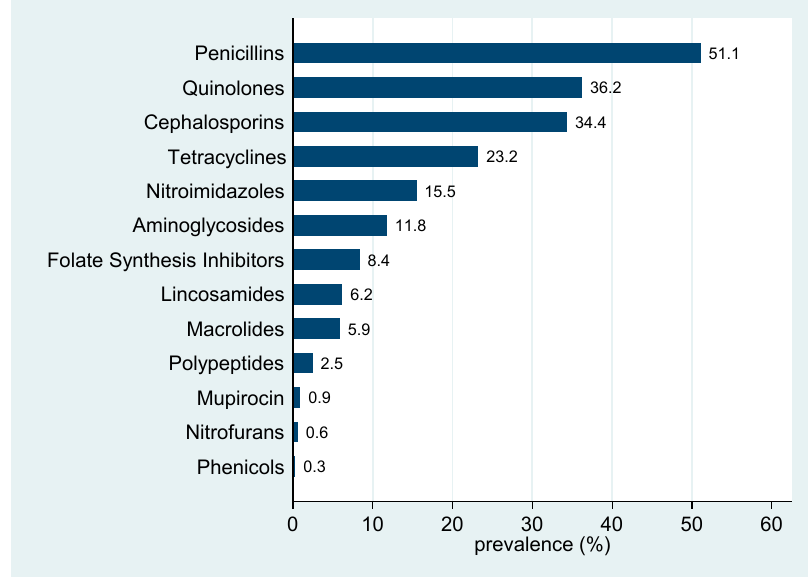
Figure 1. Prevalence of survey respondents who had used antimicrobial agents from each class in the previous 2 months ( n = 323).